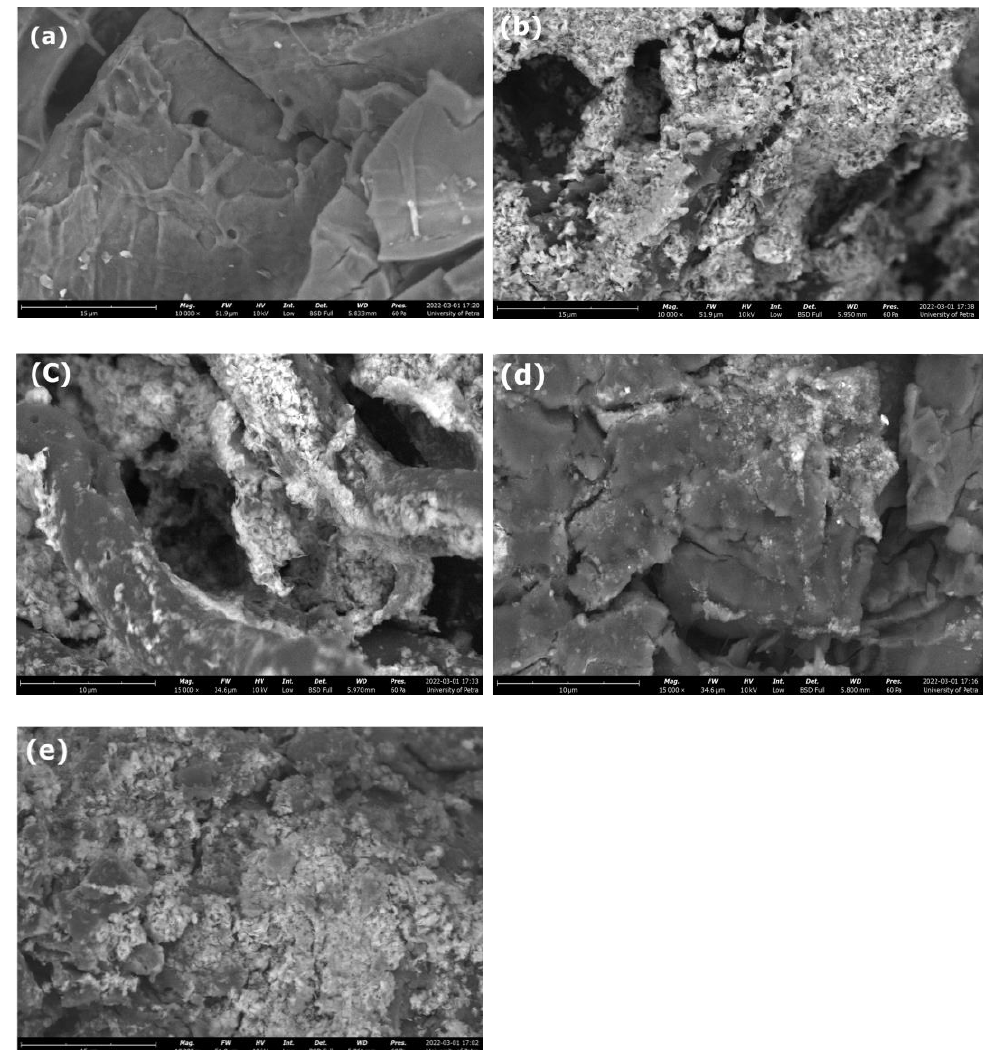
Figure 2. SEM analysis of ( a ) oak cupule powder O , ( b ) oak cupule powder coated with ZnO COZ , ( c ) COZR , ( d ) COZY , ( e ) COZE .